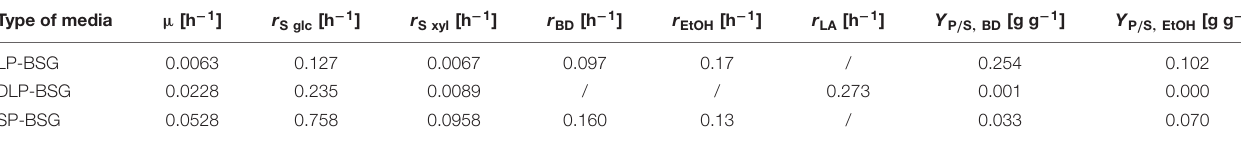
TABLE 4 | Bioprocess efficiency parameters during cultivation of bacterium P. polymyxa DSM 742 on media with different BSG hydrolysates. Type of